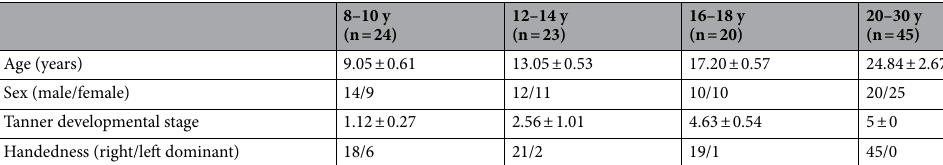
Table 1. Participant characteristics. Continuous values are presented as mean values ± standard deviation of the mean (SD). Categorical values are presented as counts.